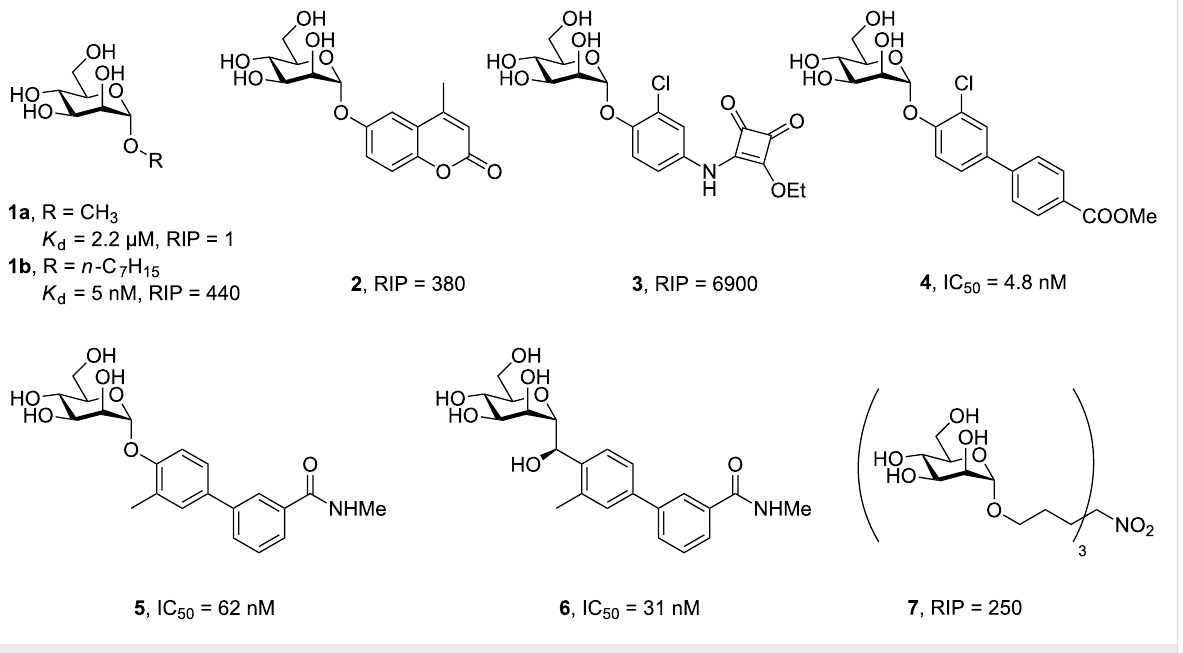
company Fimbrion (St Louis, MO) in collaboration with Glaxo-